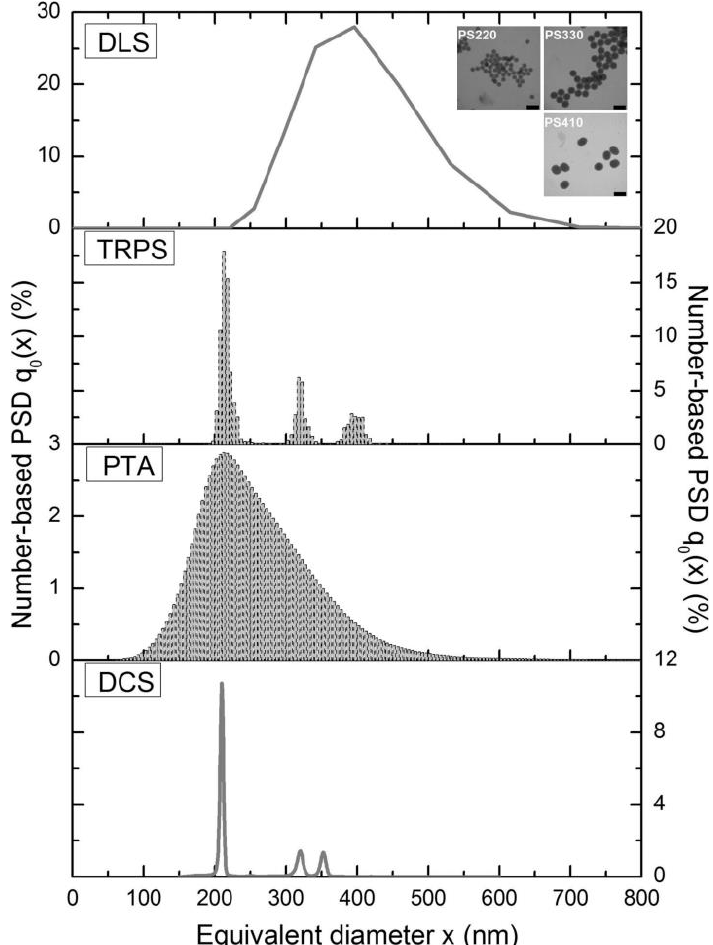
Figure 7. Comparison study of dynamic light scattering, tunable resistive pulse sensing, nanoparticle tracking analysis, and disc centrifugation concerning the resolution of a trimodal polystyrene particle suspension. Three polystyrene particle standards with sizes of 220, 330, and 410 nm—as seen in the images—have been analyzed as a trimodal mixture. This mixture was subsequently analyzed by dynamic light scattering (DLS), (nano-)particle tracking analysis (PTA), disc centrifugation (DCS), and tunable resistive pulse sensing (TRPS). In result only TRPS showed sufficient accuracy, resolution, and precision for the polymodal suspension. Adapted with permission from [34], Elsevier, 2013.